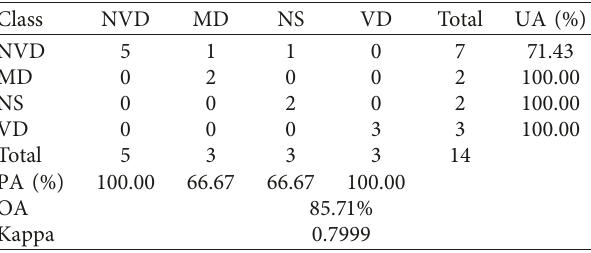
Table 9: Error matrices showing the overall accuracy and kappa for the classification of the four soil classes, nonvitrified dung (NVD), middens (MD), nonsites (NS), and vitrified dung (VD), using optimum elements ( n � 7) and the optimum bands ( n �